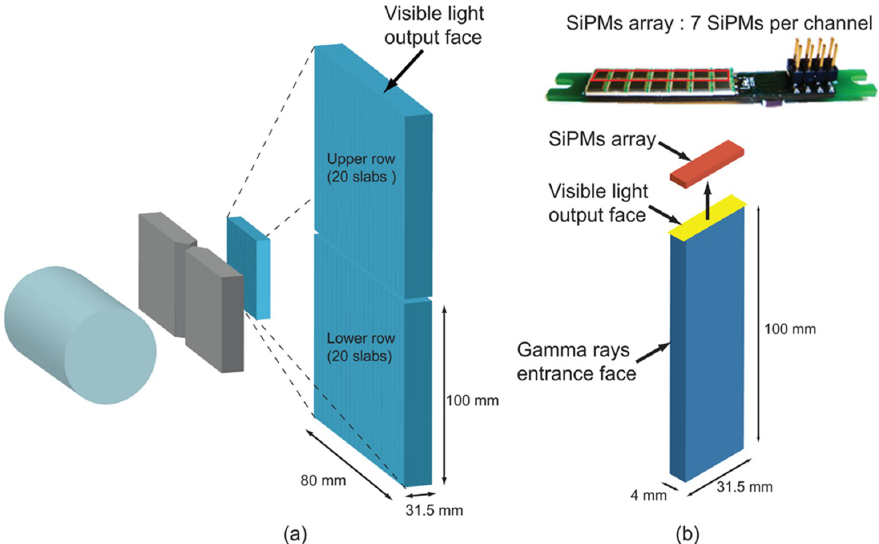
Figure 1. Design of the knife-edge slit camera. ( a ) The device consists of a tungsten collimator (grey) and a photon detector based on scintillation crystals and read out by silicon photomultipliers. 40 crystals are arranged in two rows, each with 20 slabs. ( b ) More detailed view on the readout of the scintillation crystal. With permission from [8].